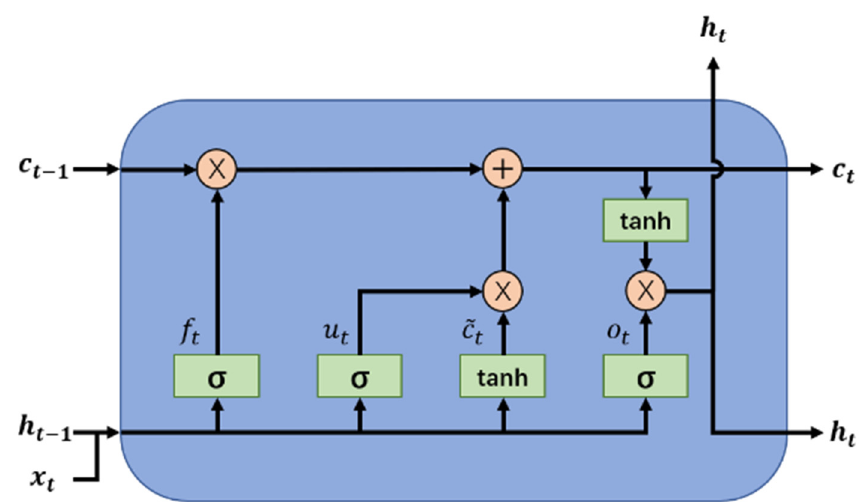
Figure 1. Structure of the LSTM unit.